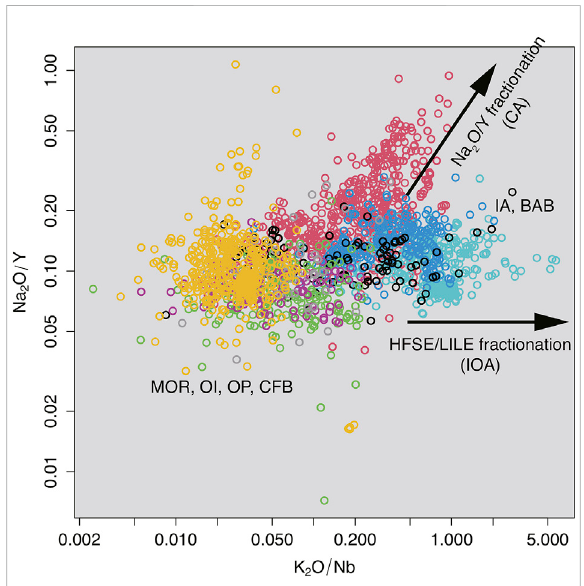
FIGURE 5 Bivariate plot of the key geochemical features for CA (Na 2 O/ Y) and IOA settings (K 2 O/Nb). Symbols are as in Figure